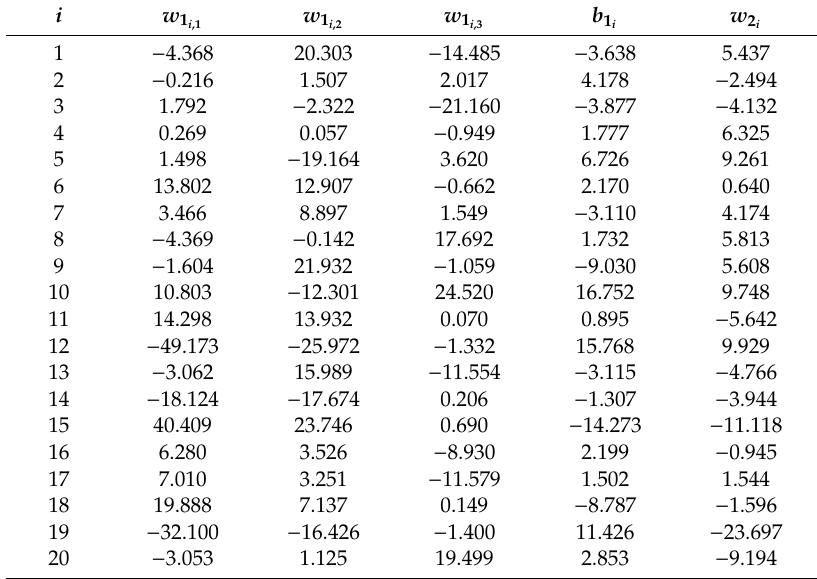
Table 3. The extracted weight and biases of the hidden layer of the optimized ANN